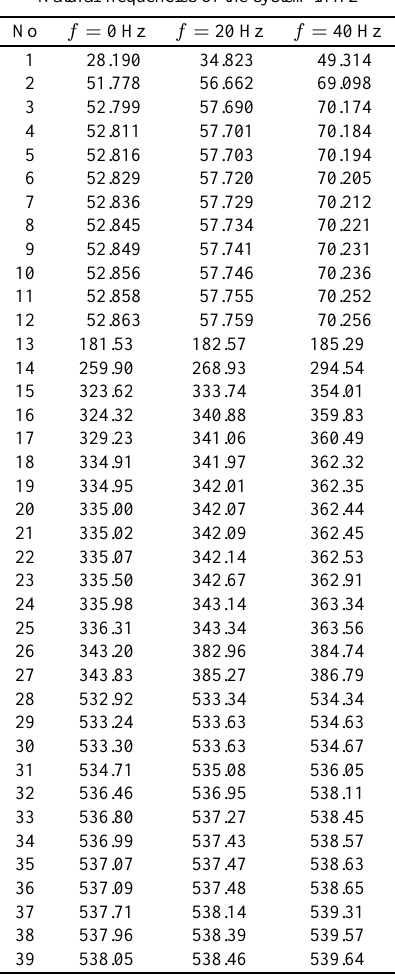
Table 3 Natural frequencies of the system in